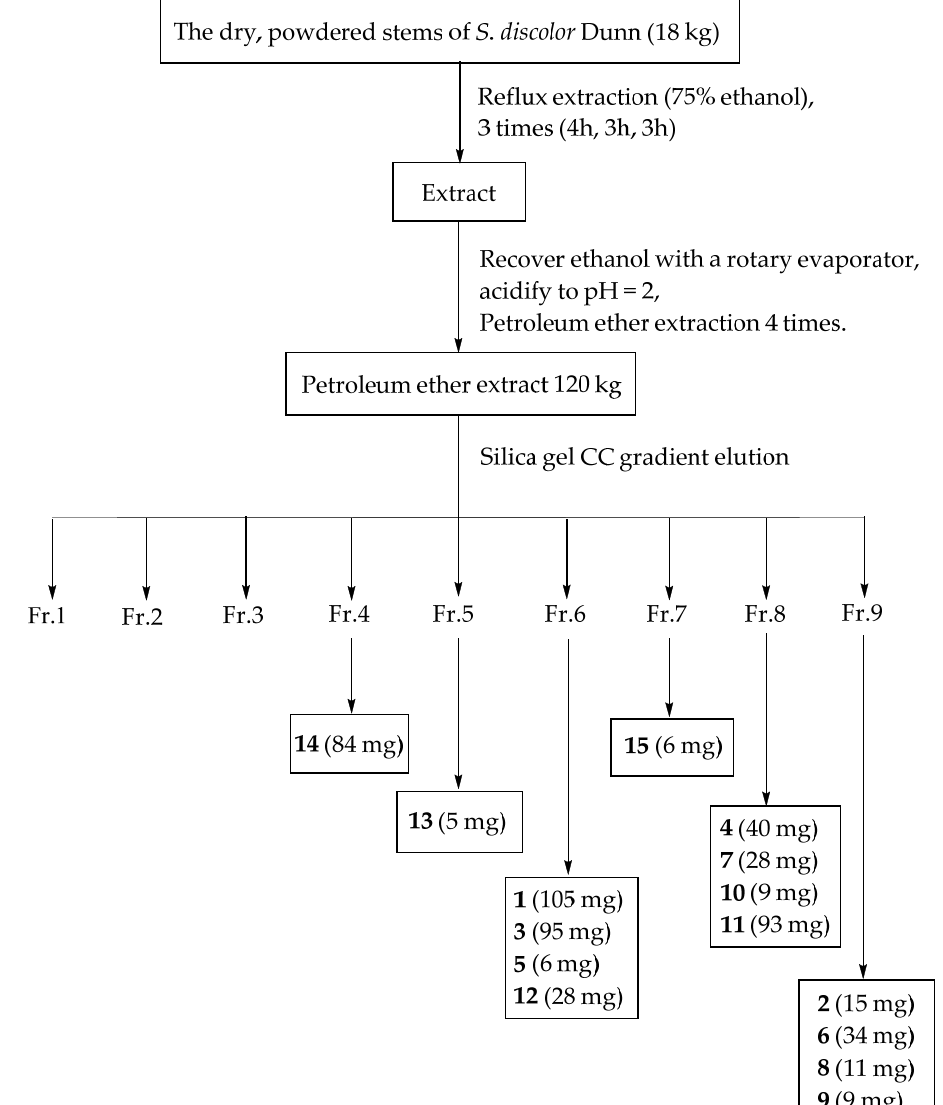
Figure 6. Separation process of chemical constituents from S. discolor Dunn.